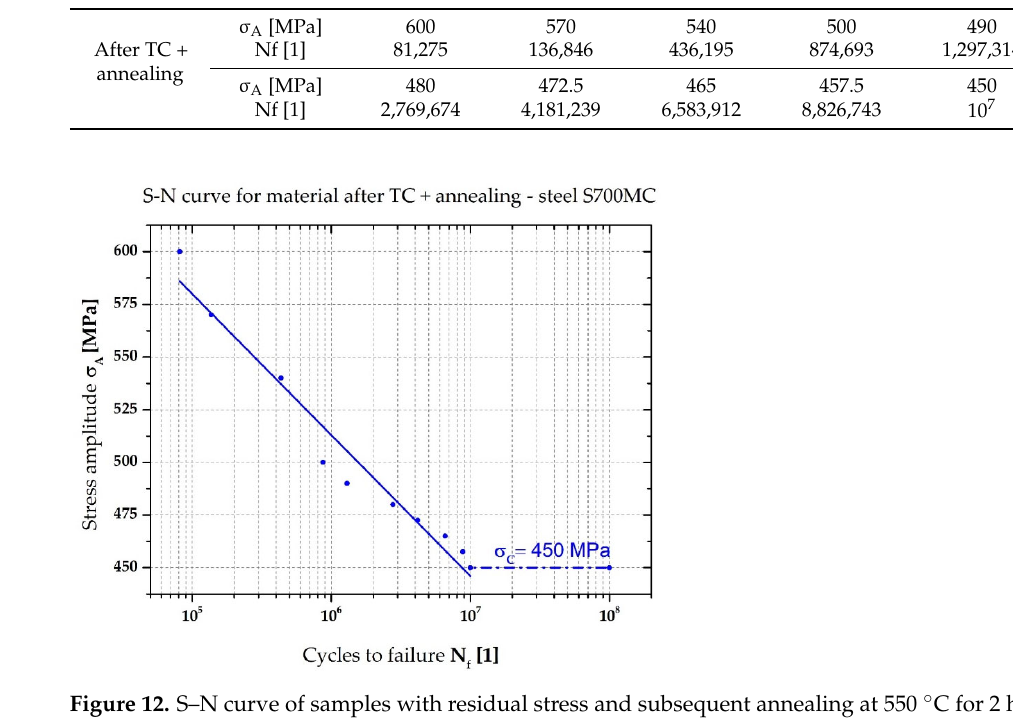
Table 5. Results of fatigue tests of samples after TC and annealing 550 °C for 2 h.